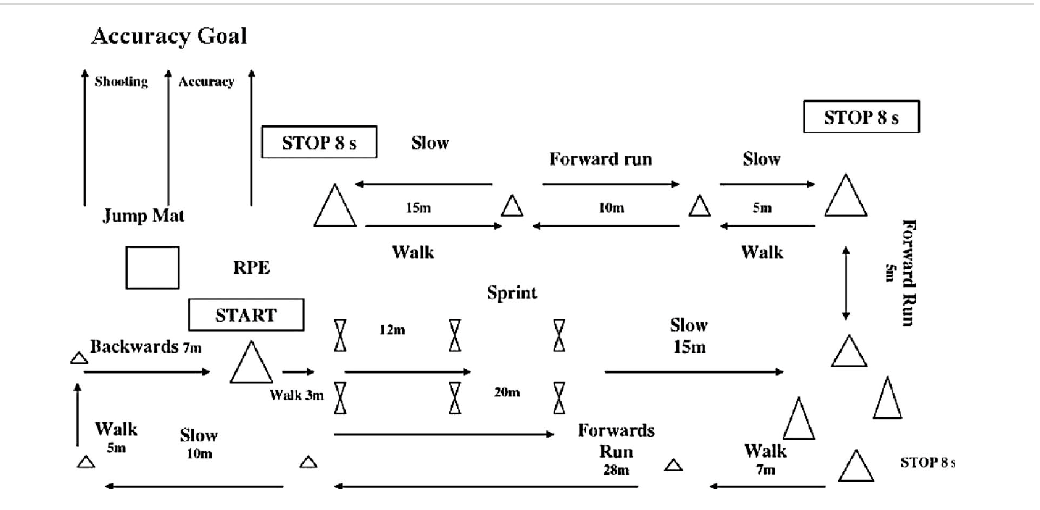
Figure 1. Design of the 90-min ball-sport endurance and sprint test (BEAST 90 , from Williams, Abt and Kilding